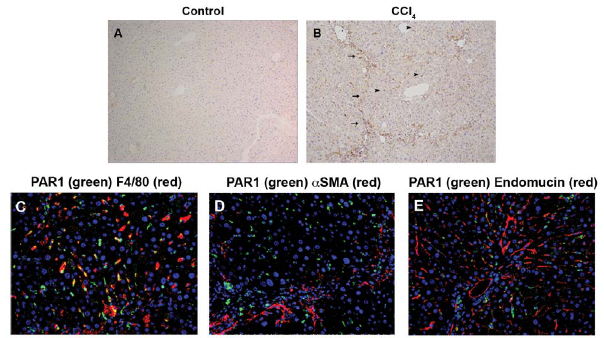
Figure 1. Hepatic PAR1 is up-regulated during liver injury and is expressed on liver macrophages. (A–B) In wild-type mice, there is a marked up-regulation of hepatic PAR1 (brown, 6 100) after carbon CCl 4 injury on cells along the hepatic scars (black arrows) and within the lobule itself (black arrowheads). (C–E) PAR1 (green) is commonly co- localised to macrophages (C, F4/80, red), but only occasionally to myofibroblasts (D, a SMA, red) and hepatic endothelium (E, endomucin, red). (Fluorescence images at 6 200 magnification, nuclei in blue.) doi:10.1371/journal.pone.0086241.g001 PLOS ONE |